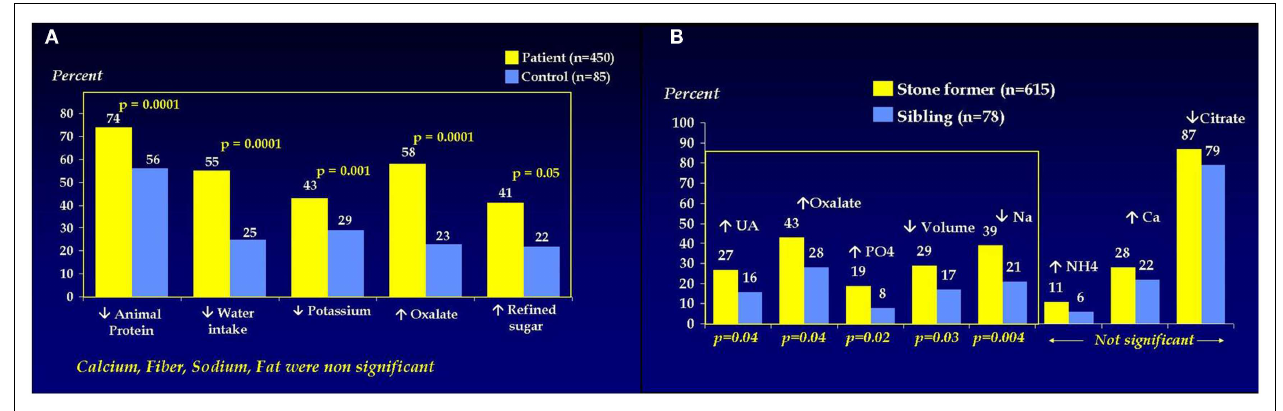
FIGURE 2 | (A) Dietary risk factors in pediatric stone formers. (B) Urinary risk factors in pediatric stone